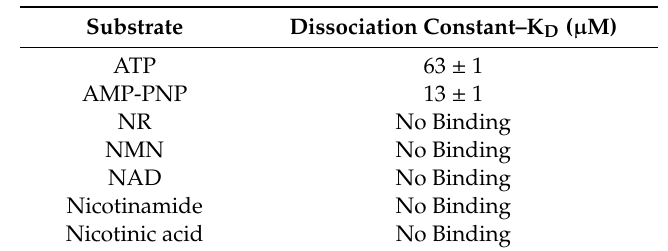
Table 1. Substrate binding studied by isothermal titration calorimetry (ITC) with NadR protein from L. lactis .